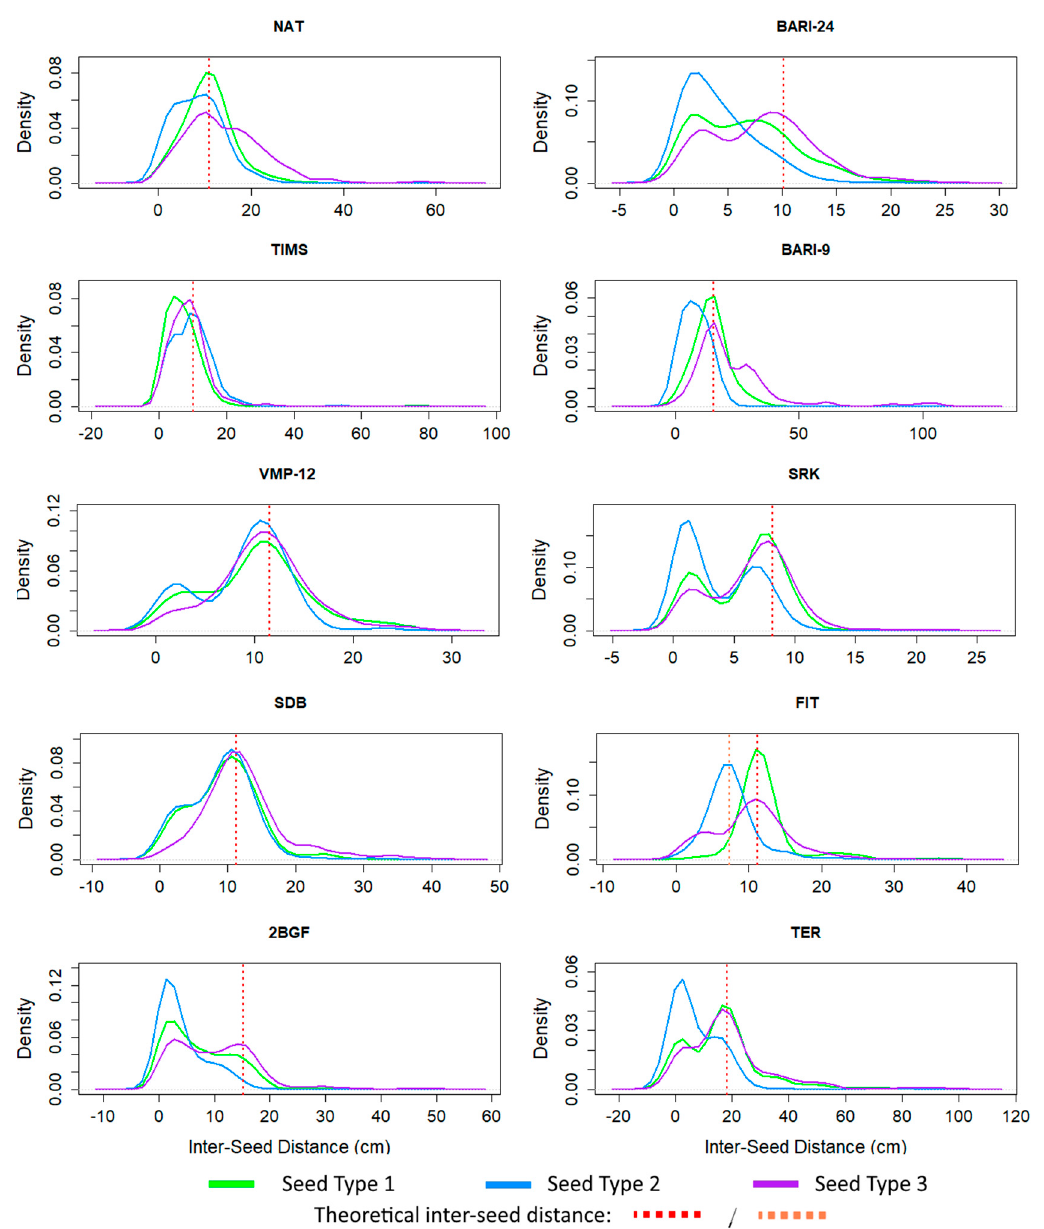
Figure 6. Probability density functions of the spatial in-row seed distances for the three seed types (Seed type 1—medium round, Seed type 2—small drop-shaped and Seed type 3—flat and large) as estimated for each seed meter. The vertical dotted line indicating theoretical inter-seed distance per meter, with the second orange dotted line representing this value for a second plate used with the FIT meter for seed type 2.